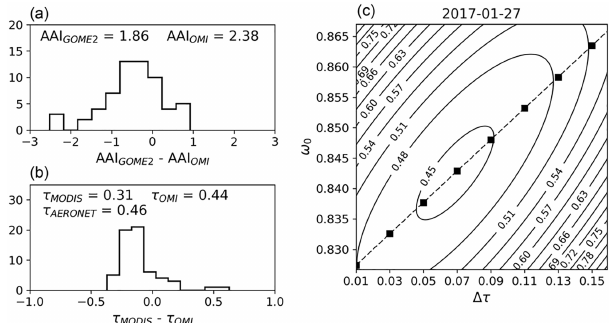
Figure 10. Histogram of (a) the AAI difference between GOME- 2 and OMI, compared to (b) the τ difference at 550nm between MODIS and OMI for 27 January. Contour of (c) the AAI RMSE as a function of variation in τ and ω 0 for 27 January. The dashed line is the best estimation for each pair of (cid:49)τ and ω 0